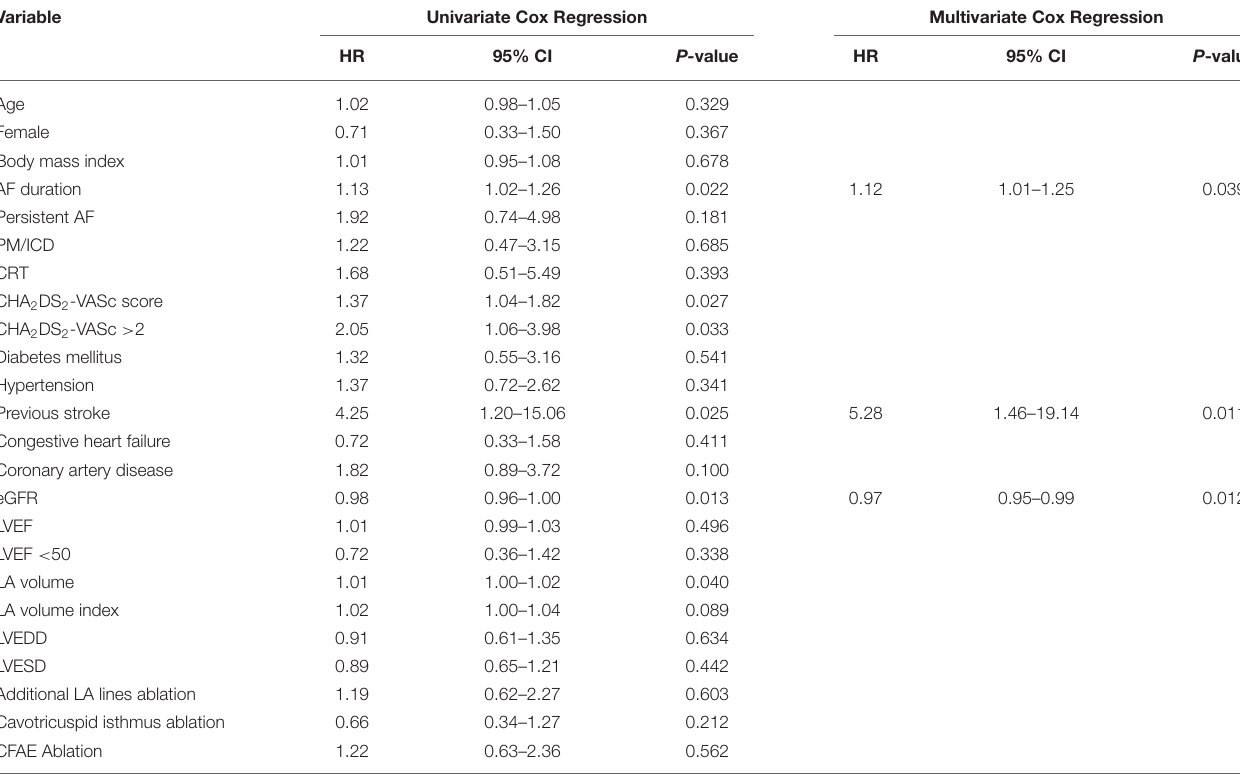
TABLE 3 | Univariate and multivariate predictors of recurrence of atrial fibrillation after the first ablation procedure.